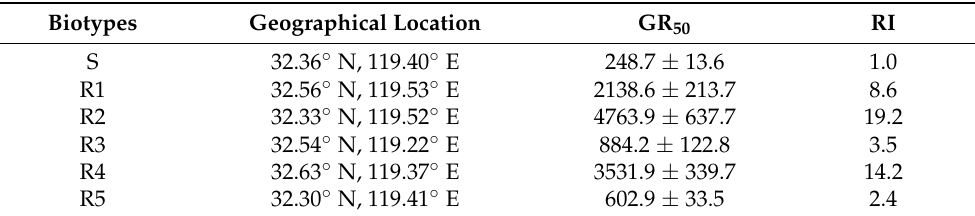
Table 1. Geographical location of six E. indica biotypes and herbicide rates causing 50% growth reduction (GR50) for the S and R